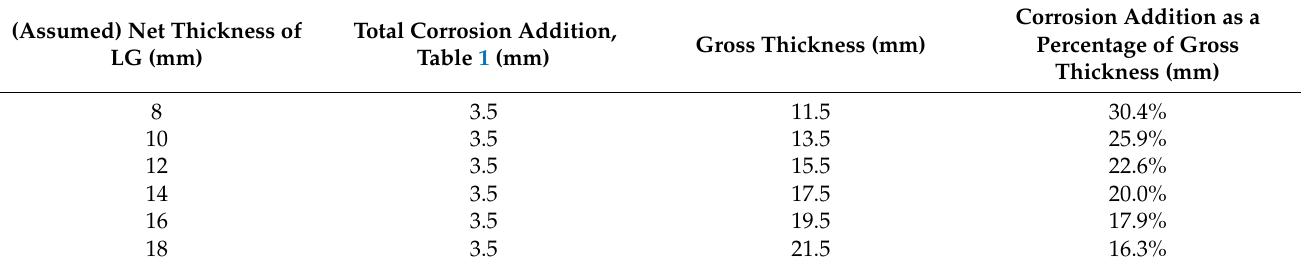
Table 2. Corrosion addition percentage and gross thickness for the LG of bulk carriers calculated according to IACS [6].